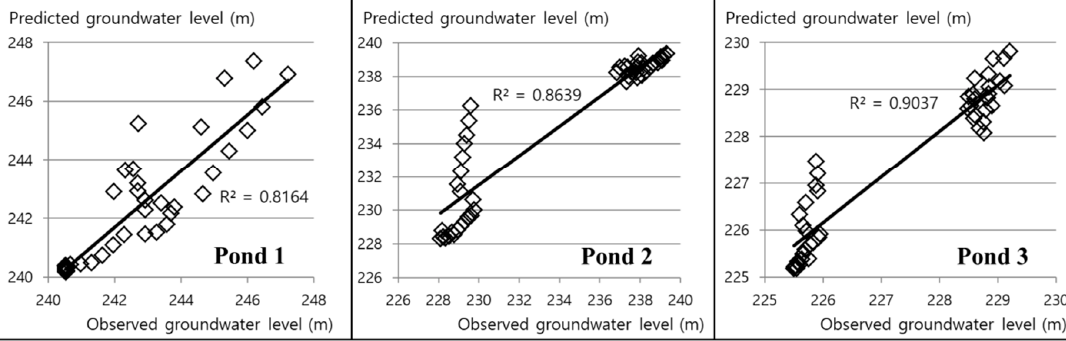
Figure 12. Scatter plots of simulated and observed groundwater levels at the three ponds in the Dalsung copper mine.